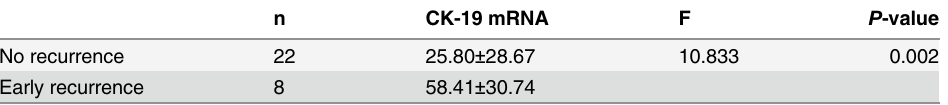
Table 3. Relationship between CK-19 mRNA and early recurrence (DFS < 12 months) in patients with an AFP concentration of < 400 μ g/L ( n = 30).